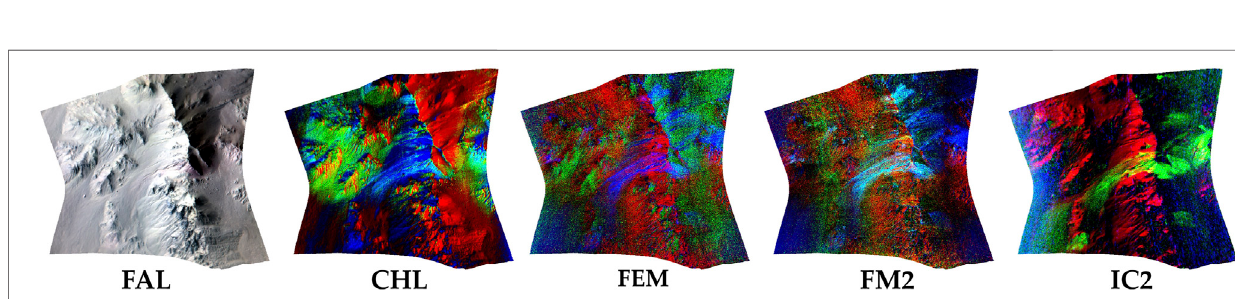
FIGURE 11 | CRISM Browse products results in South-West Asimov Crater. Footprints of data are shown with red polygons in Figure 2 .